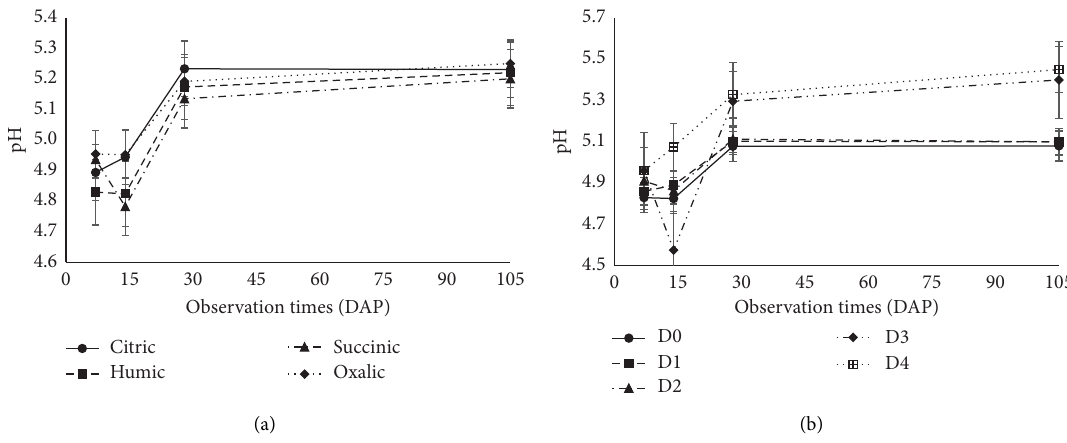
Figure 1: Efect of OA types (a) and OA concentration levels (b) on soil pH at some observation